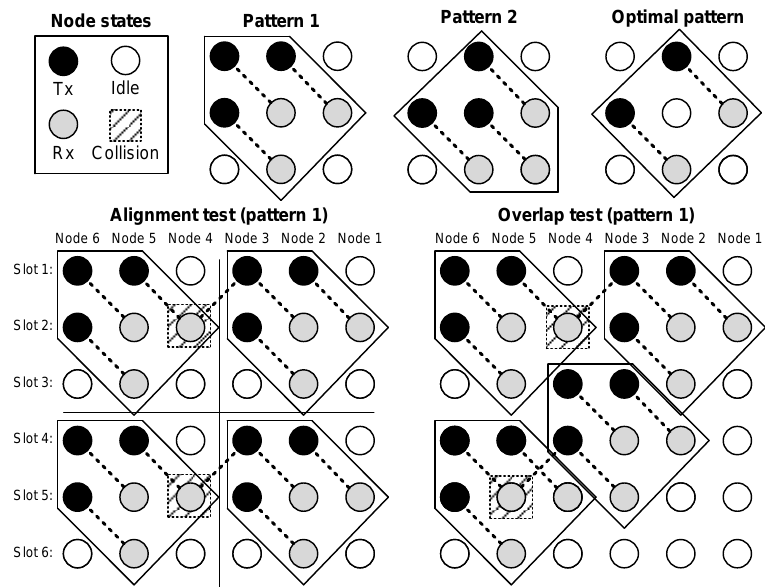
Figure 6. Example search of the optimal schedule for a string network with six nodes. In the upper-left corner, there is the legend. To its right, the three patterns considered (1, 2, and optimal) with a size of 3 × 3 (time slots × nodes). At the bottom, test results for pattern 1 are shown: alignment (left) and overlap (right). Both tests indicate collisions in the 2D space-time lattice, so pattern 1 is not a valid pattern.